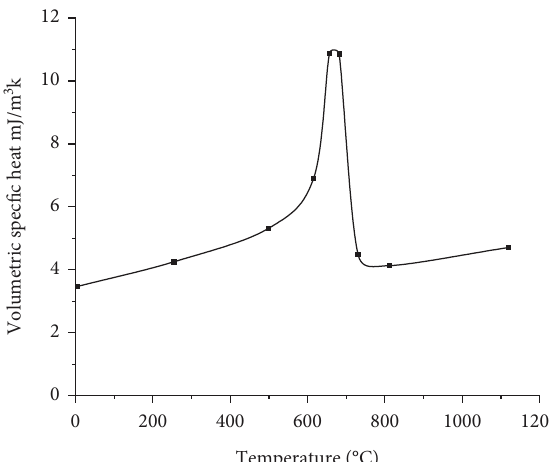
Figure 13: Tensile strength reduction factor at elevated temper- atures [19].